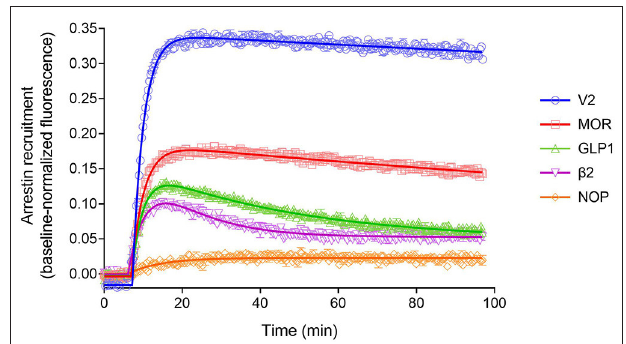
FIGURE 8 | Diversity of arrestin recruitment waveforms for GPCRs. The time course was evaluated for five GPCRs in HEK293T cells, with recruitment optimized by expression of GRK enzymes. Note the different shapes of the waveforms. For the V 2 vasopressin and µ opioid (MOR) receptors, the waveform rapidly rose to a steady-state then slowly declined. The data were fit best by a model that assumes recruitment followed by slow degradation, representing the degradation pathway in Figure 7 . For the GLP-1 and β 2 adrenergic receptors, the waveform was a rise and fall to steady-state curve, the recruitment rising rapidly, peaking, then falling back down to a steady-state level. The data were fit best by a recruitment followed by recycling model, representing the recycling pathway ( Figure 7 ). For the NOP nociceptin receptor the recruitment rose to a steady-state, the data described best by simple recruitment (over the duration of the experiment). Data points are the mean ± SEM of three technical replicates from a representative experiment, with the curve fitting performed as described in Materials and Methods. GRK2 was expressed in the cells to maximize recruitment for all receptors except the V 2 receptor. The curves are the fits to the model that fit the data best [recruitment and degradation model ( Figure 9B ) for V 2 and MOR receptors; recruitment and recycling model ( Figure 9C ) for GLP-1 and β 2 receptors; and recruitment alone model for the NOP receptor ( Figure 9A )]. The curve fit parameter values are in Table 3